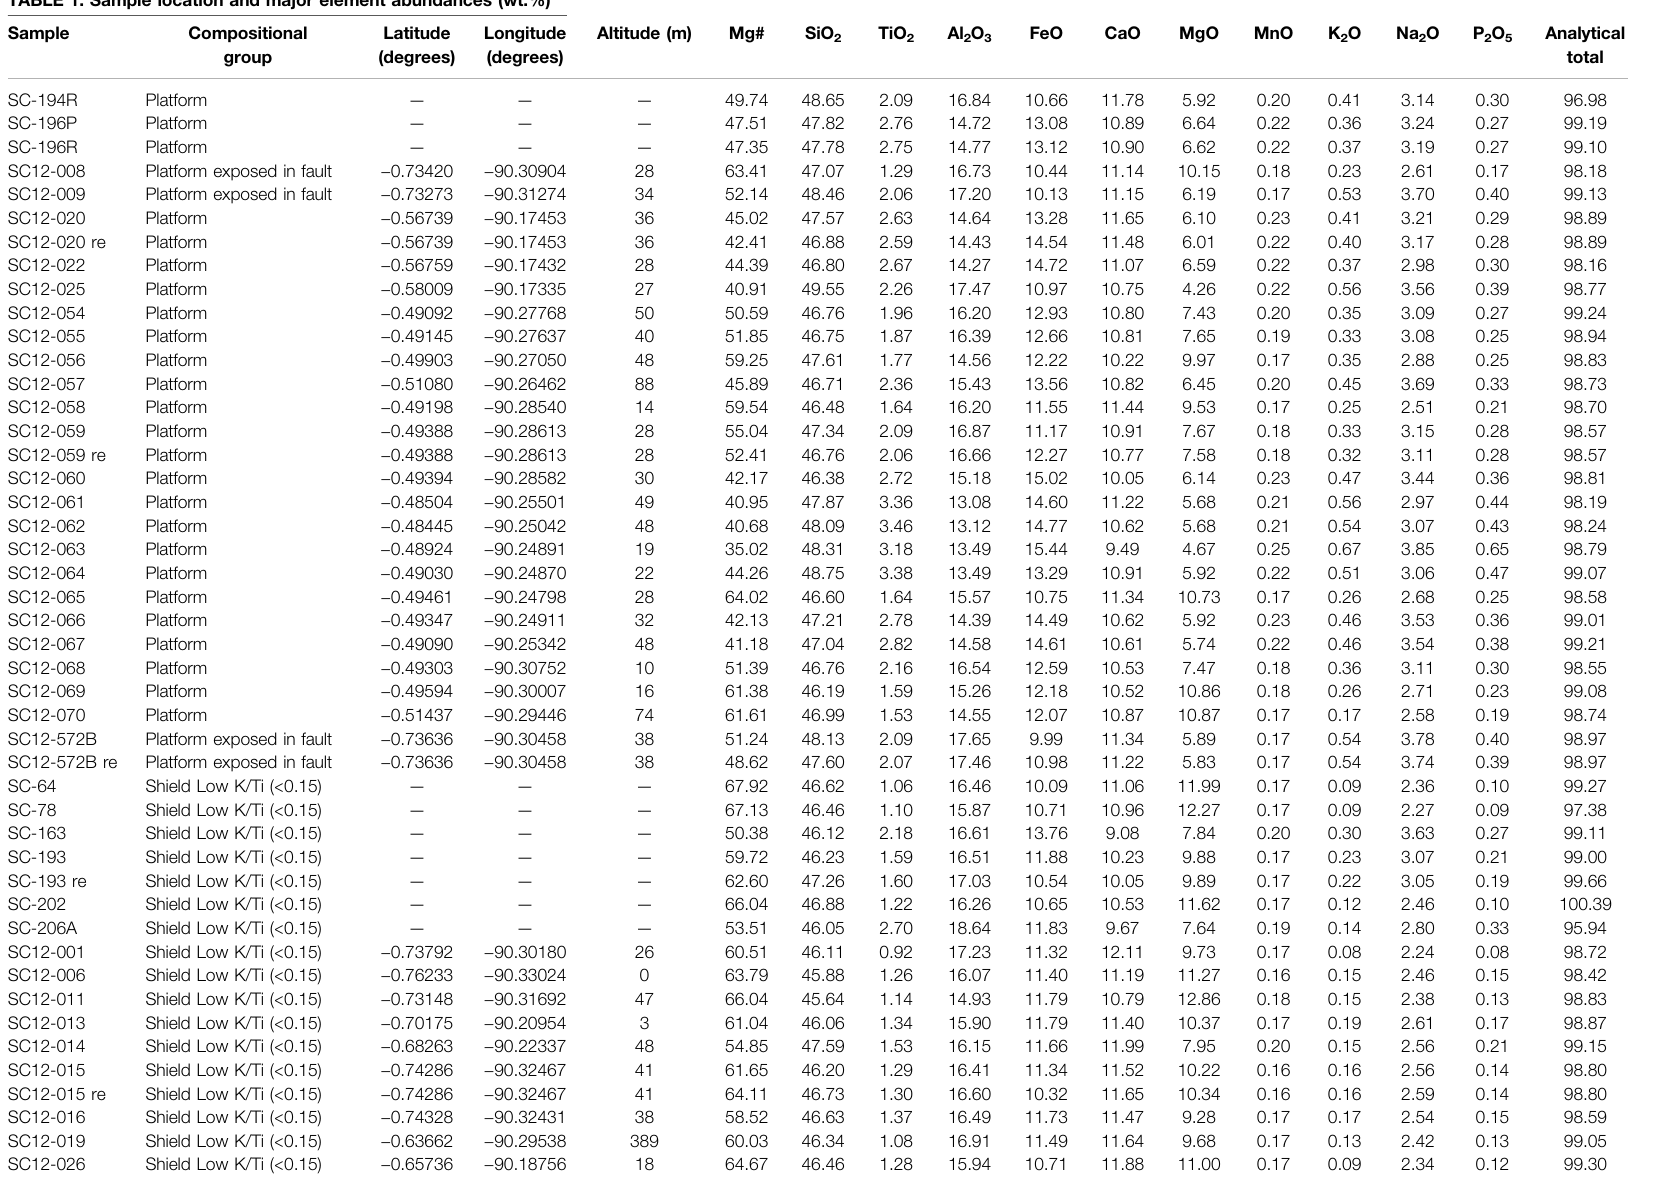
TABLE 1 | Santa Cruz sample locations and major element contents. TABLE 1: Sample location and major element abundances (wt.%)